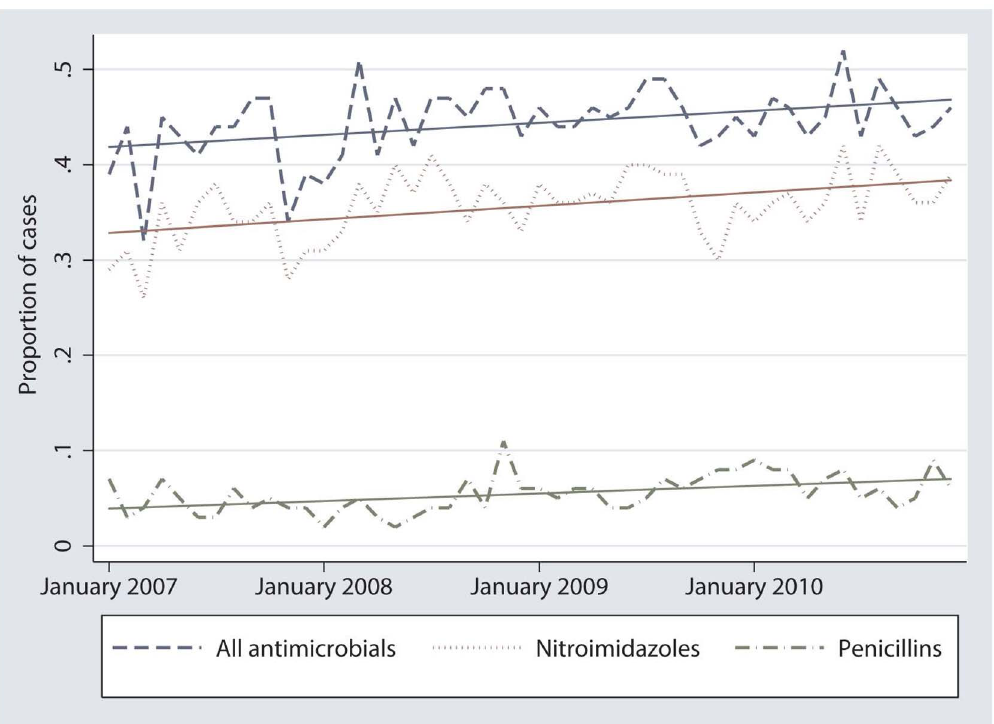
Figure 2. Changes in the proportion of companion animal diarrhea cases (n=15,928) treated with any antimicrobial, nitroimidazole class and penicillin class from January 1, 2007 to December 31, 2010.